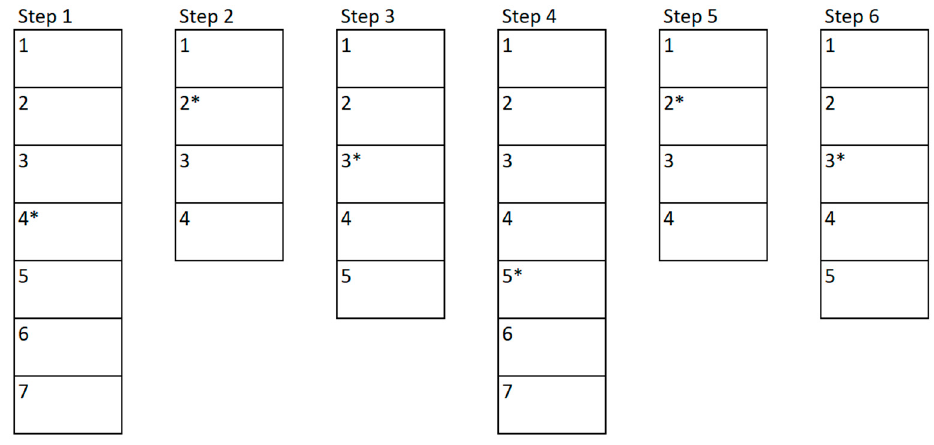
Figure 3. An exercise consists of several steps, and each step, in turn, consist of difficulty levels.